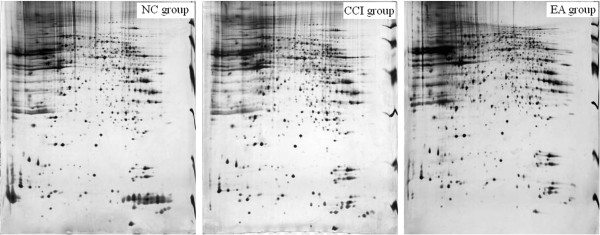
Hippocampal tissue protein profiles obtained with silver stained gels from the three groups.